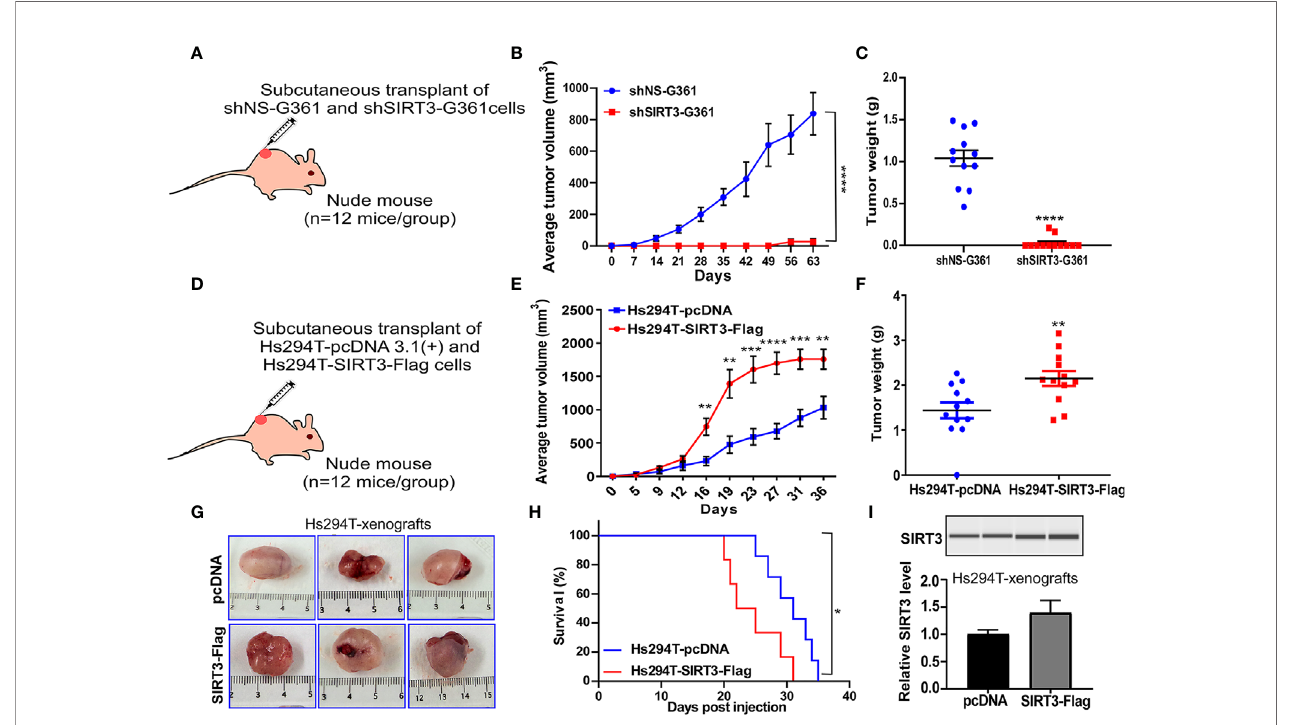
FIGURE 1 | Effect of SIRT3-knockdown (shSIRT3-G361) and overexpressing (Hs294T-SIRT3-Flag) melanoma cells in Nu/Nu mouse xenografts. SIRT3-knockdown and overexpressing melanoma cells were xenografted in Nu/Nu mice and followed for tumorigenesis. (A) SIRT3-knockdown study design, (B) Average tumor volume, and (C) Tumor weight for shNS-G361 and shSIRT3-G361 melanoma cells xenografted tumors (at the termination of the experiment). (D) SIRT3- overexpression study design, (E) Average tumor volume, (F) Tumor weight (at the termination of the experiment), (G) Representative images of tumors with scale bars, and (H) Survival probability analysis for Hs294T-empty vector pcDNA 3.1(+) (control) and Hs294T-SIRT3-Flag (SIRT3-overexpressing) melanoma cells xenografted tumors. (I) Wes ProteinSimple analysis con fi rming SIRT3 higher expression in the derived tumor tissues. The SIRT3 quantitative data was normalized using Total Protein Assay of the same sample. N=12 mice/experimental group. Statistical signi fi cance are indicated as *p < 0.05, **p < 0.01, ***p < 0.001, ****p < 0.0001. shNS, nonspeci fi c shRNA; shSIRT3, SIRT3-knockdown; pcDNA (empty vector); SIRT3-Flag